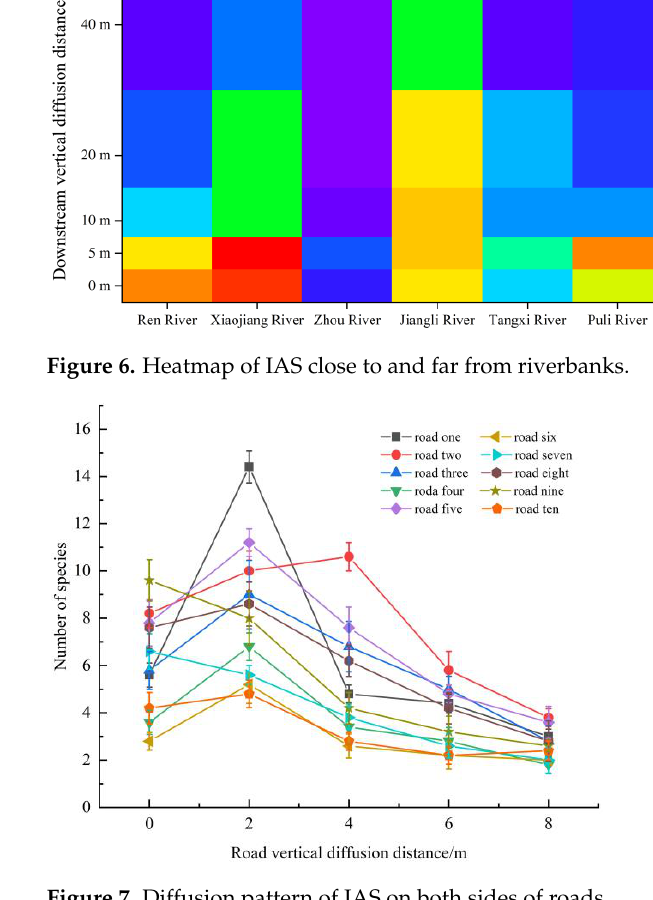
Figure 8. Distribution map of IAS. (Map serial number correspondence table is provided in Supple- mentary File S2).